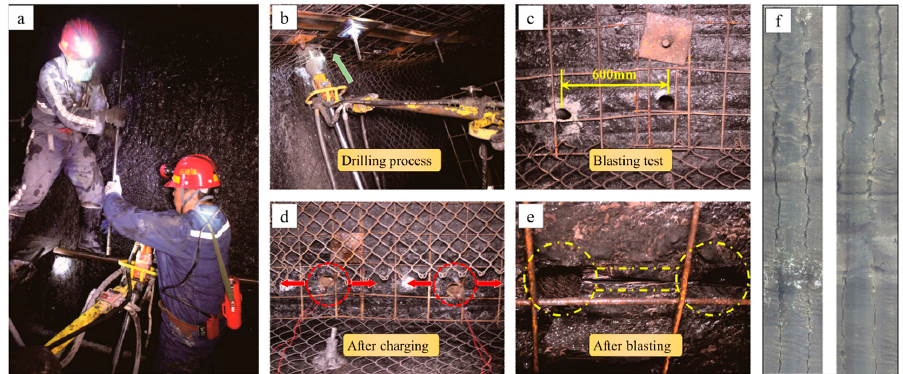
Figure 15. Roof fracturing construction process: ( a ) Installing drill stems; ( b ) Drilling holes; ( c ) Blasting test; ( d ) Charging process; ( e ) Fracture distribution at the roof surface; ( f ) Fracture